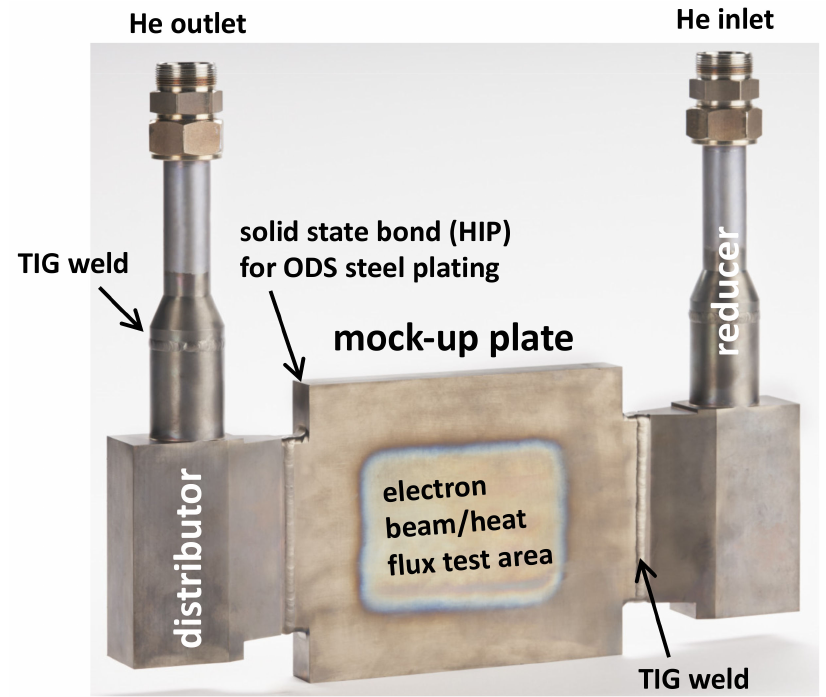
Figure 30. The design of the mock-up is illustrated by a photo that has been made after the high heat flux tests. There are 5 parts, which are joined by TIG welds (2 reducers, 2 distributors, the mock-up plate with internal cooling channels). The sixth part, an ODS plate, is joined by HIP on top of the mock-up plate.